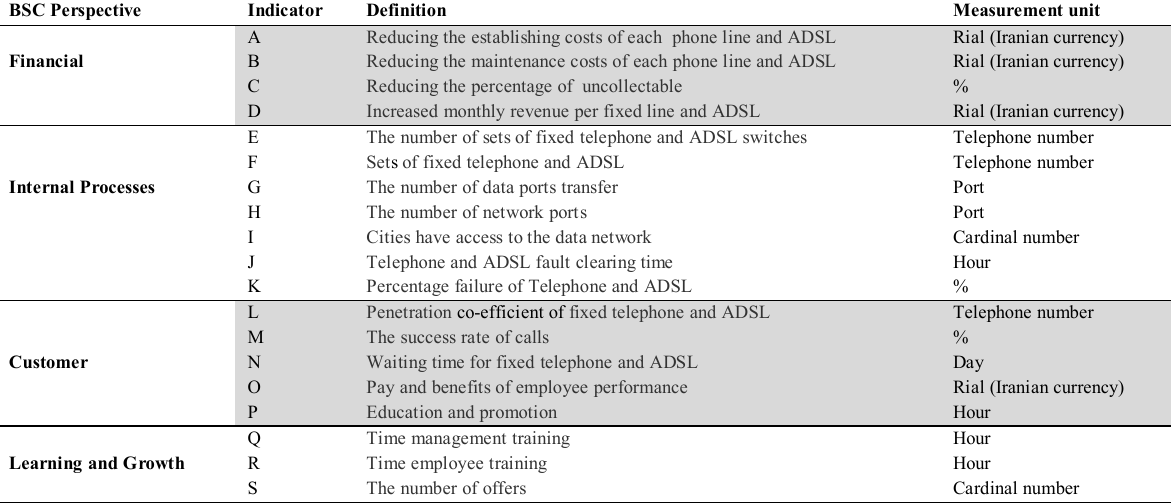
Performance indicators selected for the present study BSC